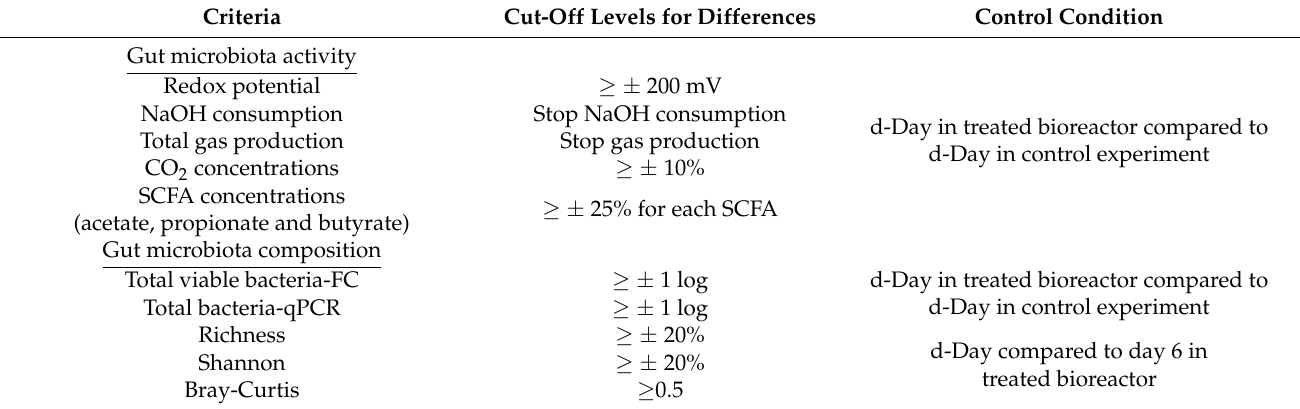
Table 2. Selected criteria used to determine dysbiosis periods in ARtificial COLon (ARCOL)